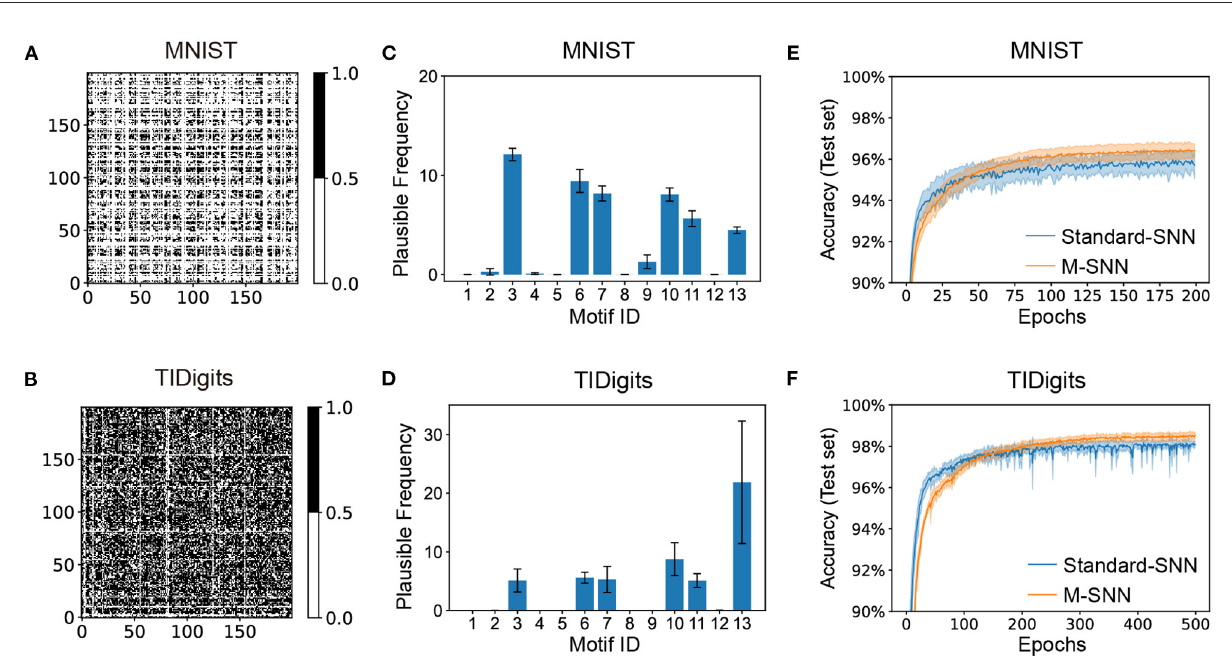
FIGURE3 Network convergence with SNNs using Motifs in different datasets. (A, B) Motif masks of MNIST (A) and TIDigits (B) after training. (C, D) Plausible Frequency of Motif distributions of MNIST (C) and TIDigits (D) datasets after training. (E, F) Convergence curve of classification task of MNIST (E) and TIDigits (F)